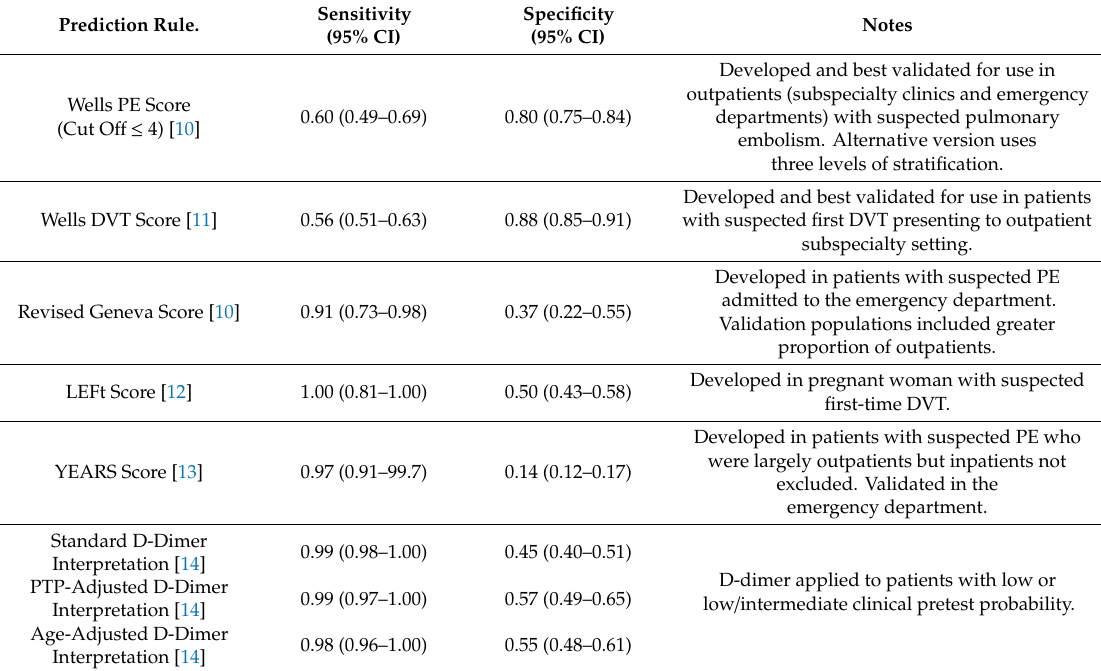
Table 1. Overview of clinical and laboratory prediction rules for suspected DVT and PE. Prediction